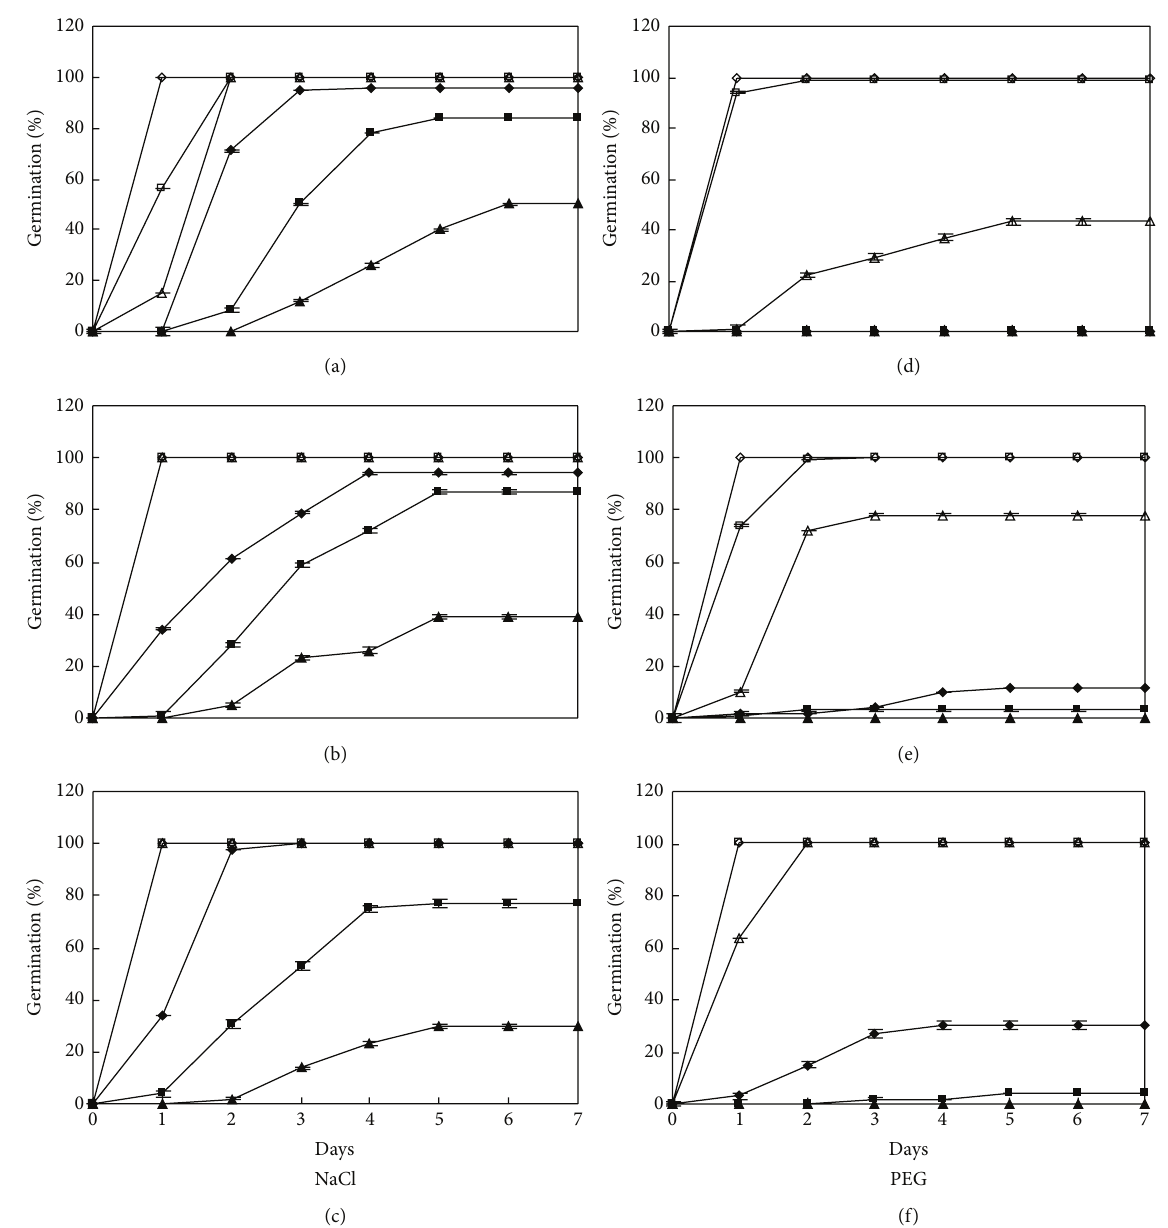
Figure 2: Germination time courses of SDM in NaCl and PEG solutions at alternating temperature regimes. See Figure 1 for symbols.